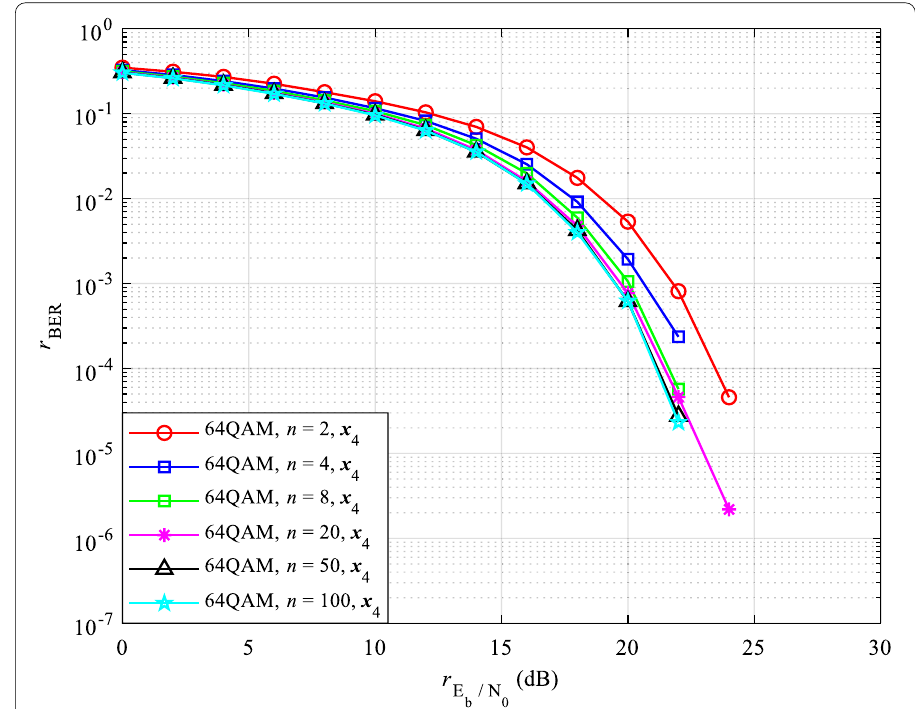
Fig. 8 BER performance of 64QAM modulated 2 pilot x 4